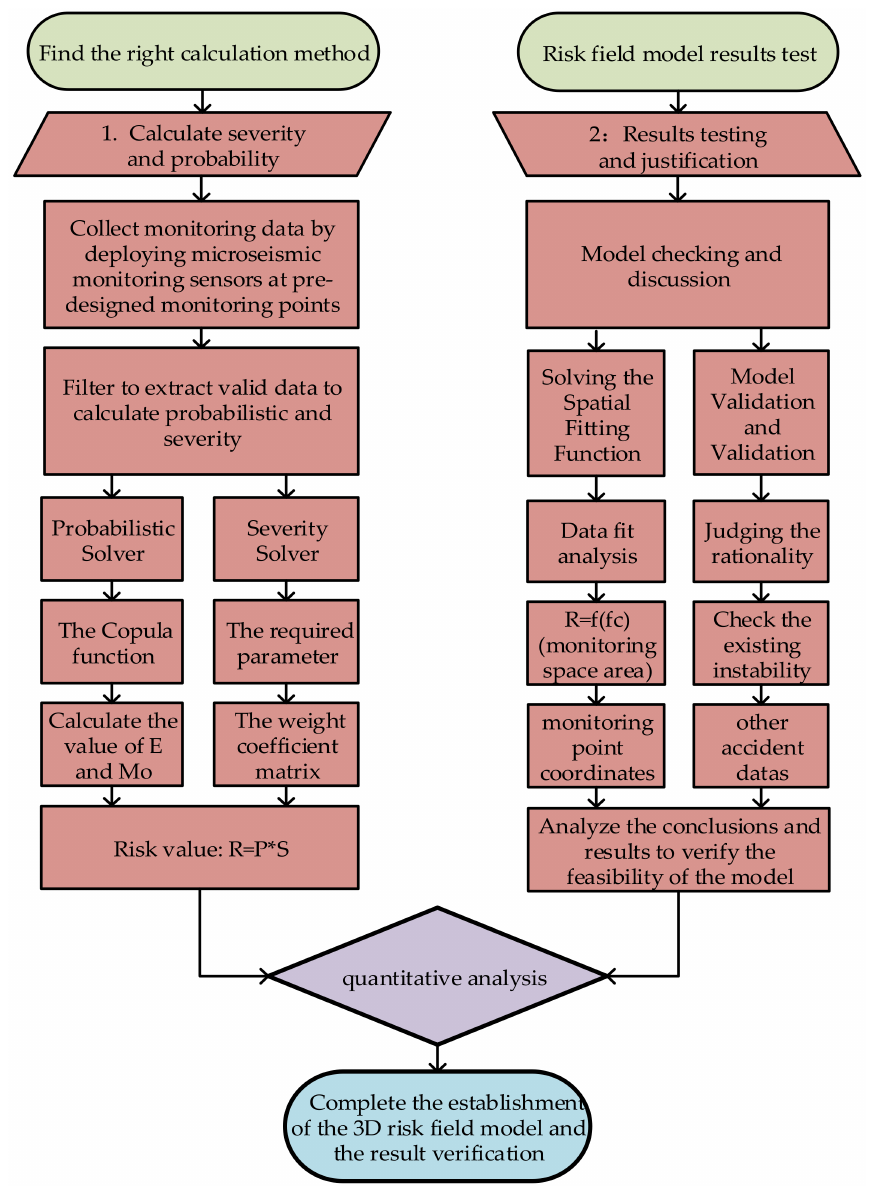
Figure 1. Flow chart showing how toestablish spatial 3D risk field prediction model based on monitoring